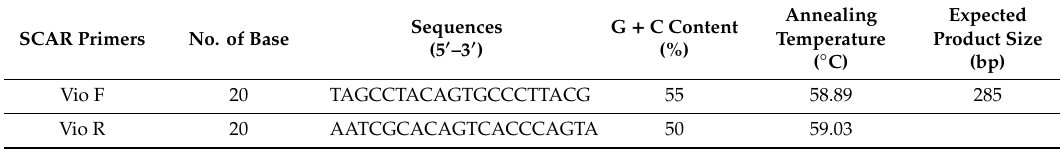
Figure 5. Amplification of accessions of Viola serpens using SCAR primers (Vio F and Vio R). Lane M = DNA marker, Lane L1–L6 = Samples of Viola serpens.